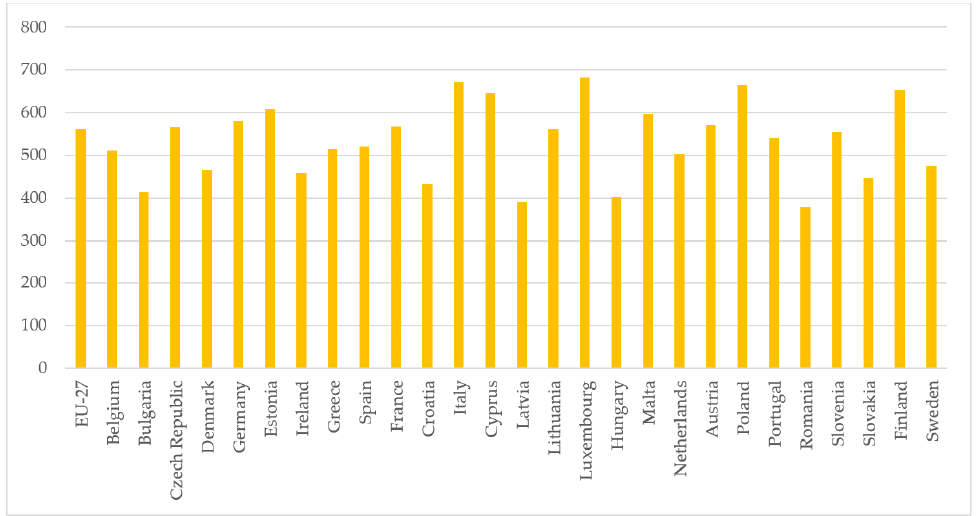
Figure 6. Passenger cars per 1000 inhabitants in EU countries in 2020, number. Source: Eurostat: [74].